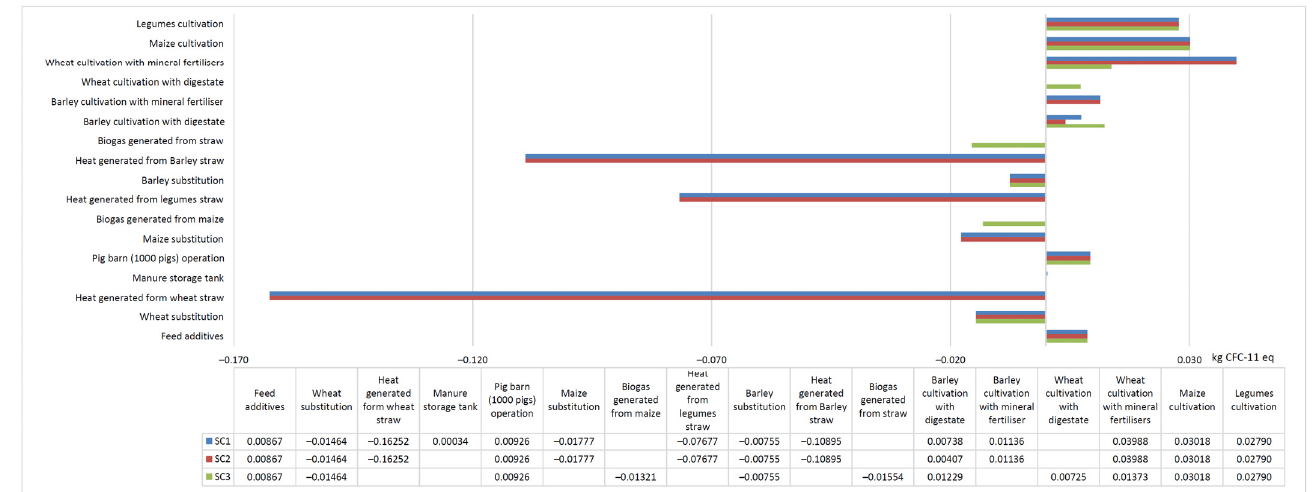
Figure 8. Results of processes for ozone layer depletion potential.